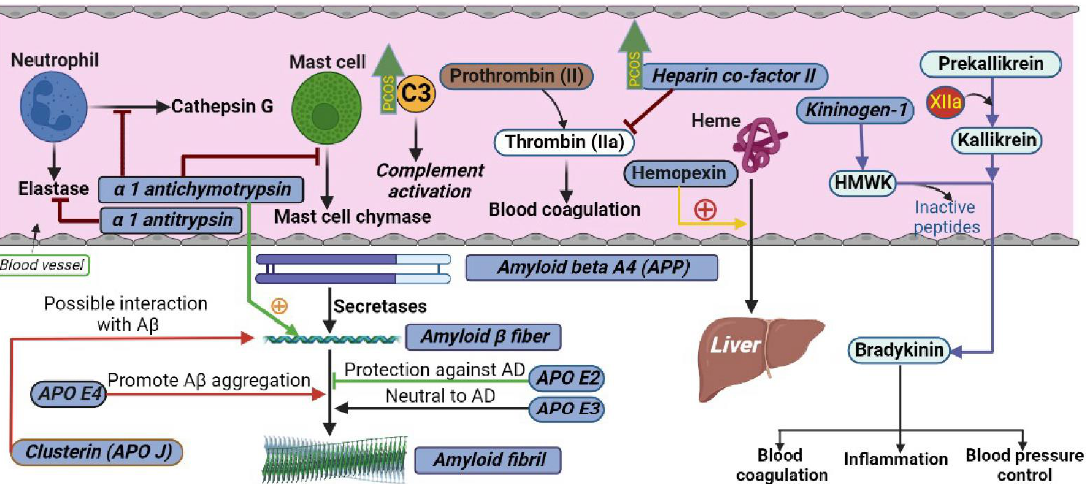
Figure 2. Schematic illustrating the interactions of proteins measured in the current study in their respective biological pathways. The levels of C3 and heparin cofactor II were higher in PCOS, as indicated by green upward arrows.